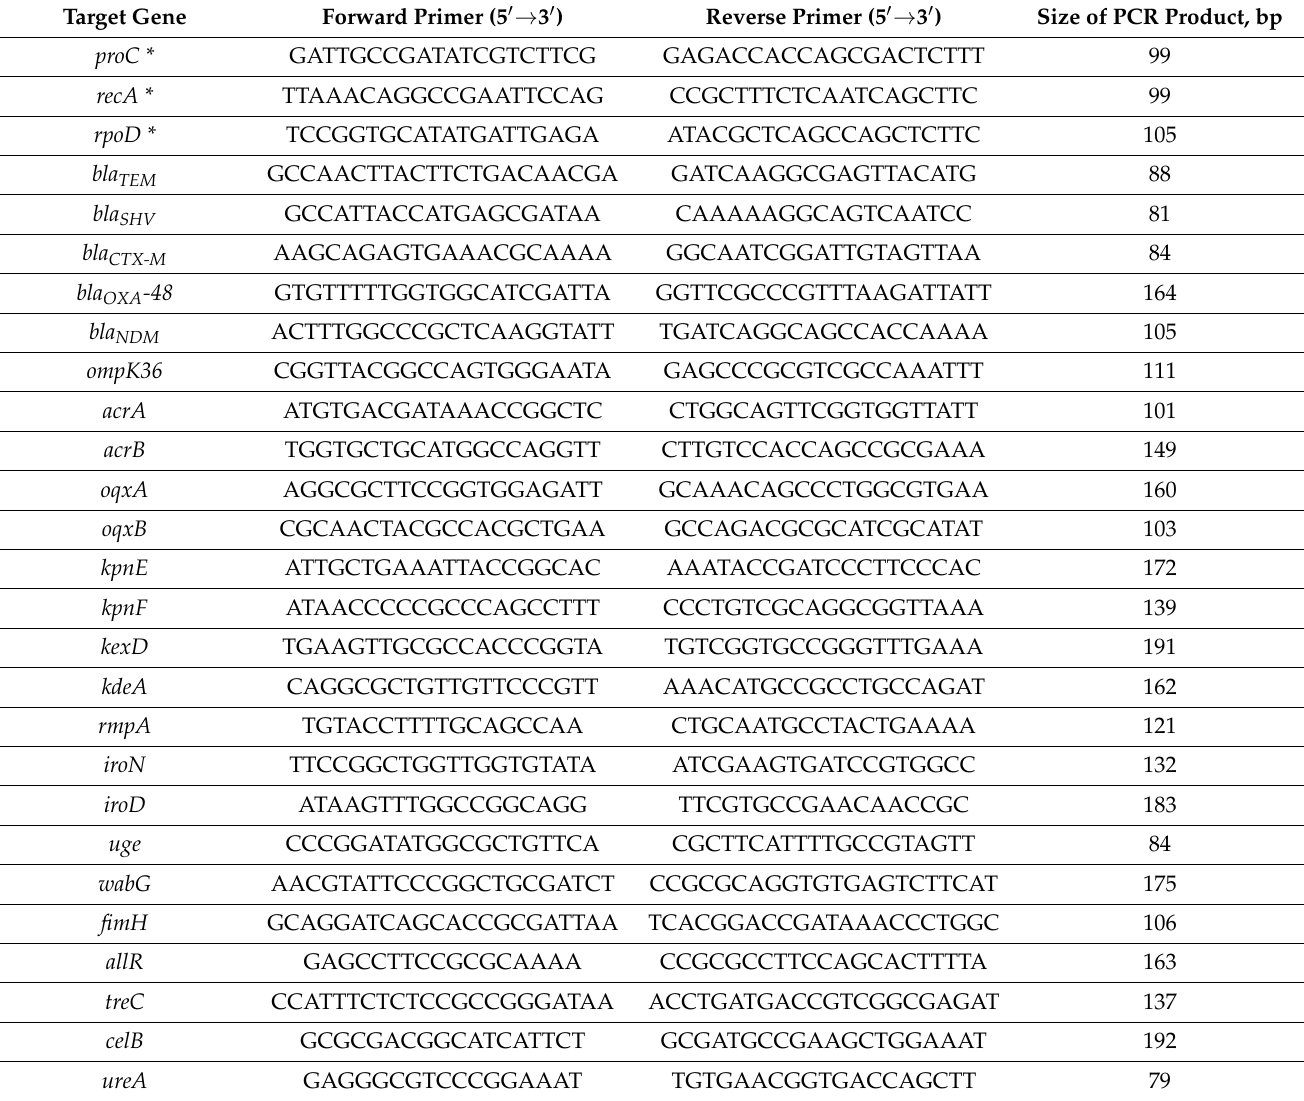
Table 2. Oligonucleotide primers for RT-PCR were used in this study for the detection of K. pneumoniae antimicrobial resistance and virulence